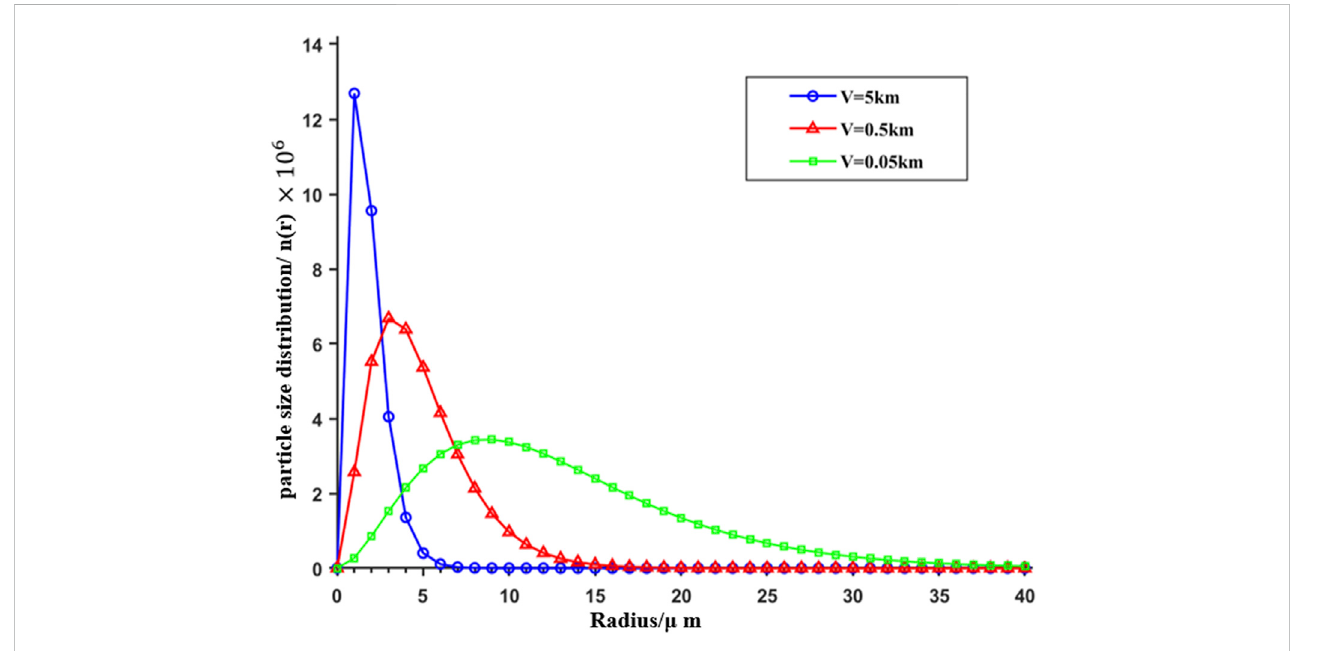
FIGURE 1 Solution process of vector radiation transmission equation based on